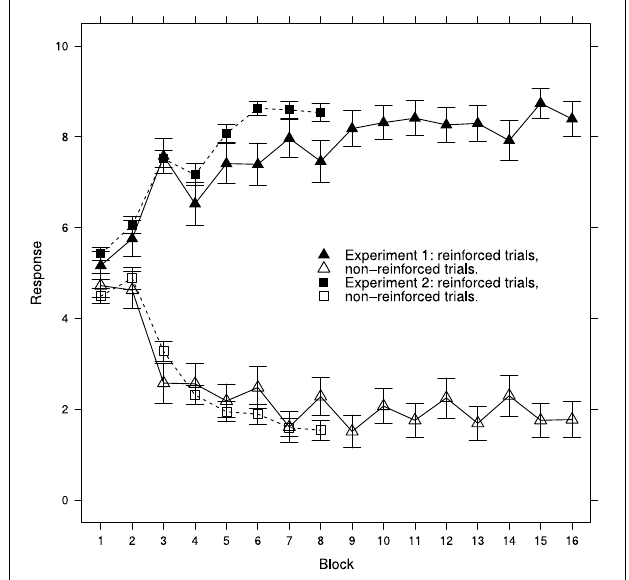
FIGURE 1 | Ratings for reinforced and non-reinforced trials mean ± standard error for Experiment 1 and Experiment 2. See Results section on page 7 for further